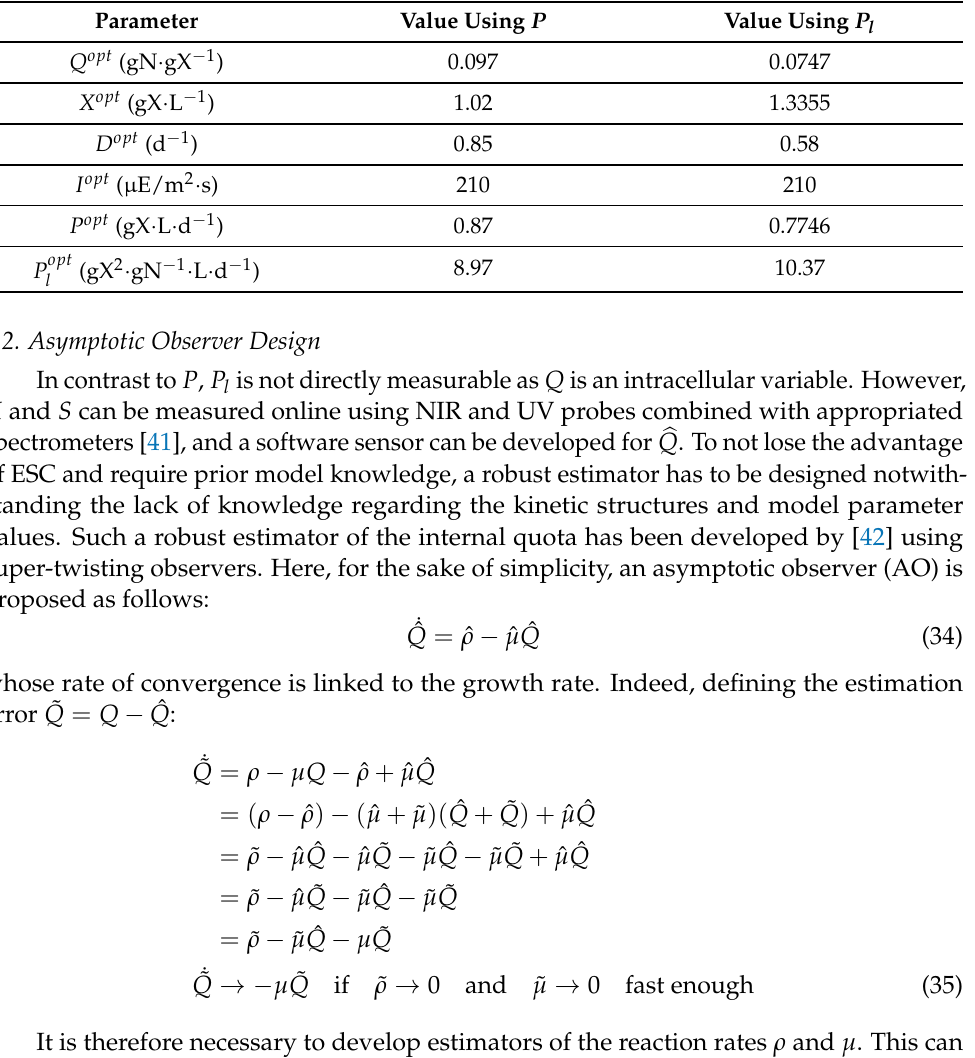
Table 3. Optimal values following bifurcation